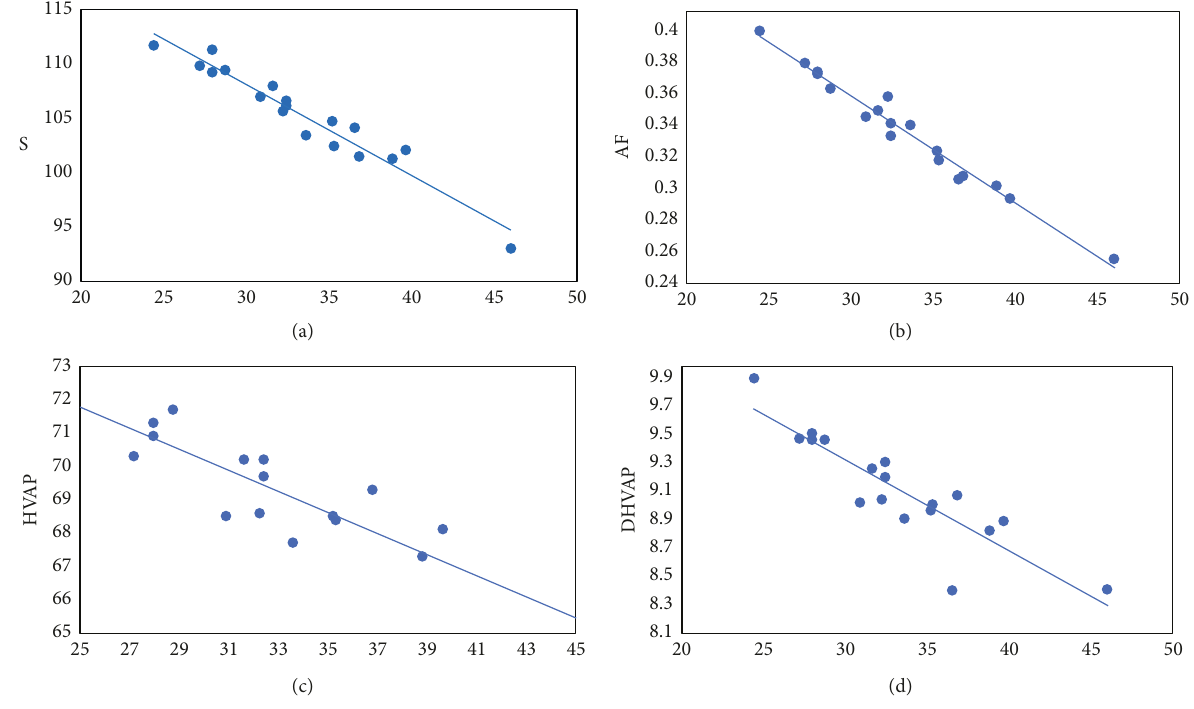
Figure 2: Correlation of GH ( x -axis) and physical properties S, AF, HVAP, and DHVAP ( y -axis).